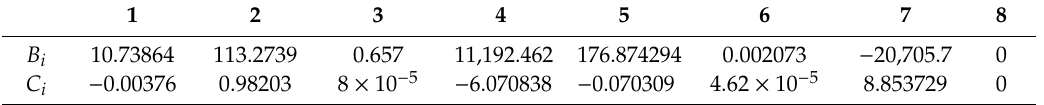
Figure 5. Photographs and schematic diagram of the desiccant wheel: ( a ) Structure of the SDP desiccant wheel. ( b ) Data point related to model establishment. Table 2. Coefficients of the dehumidification performance curve.